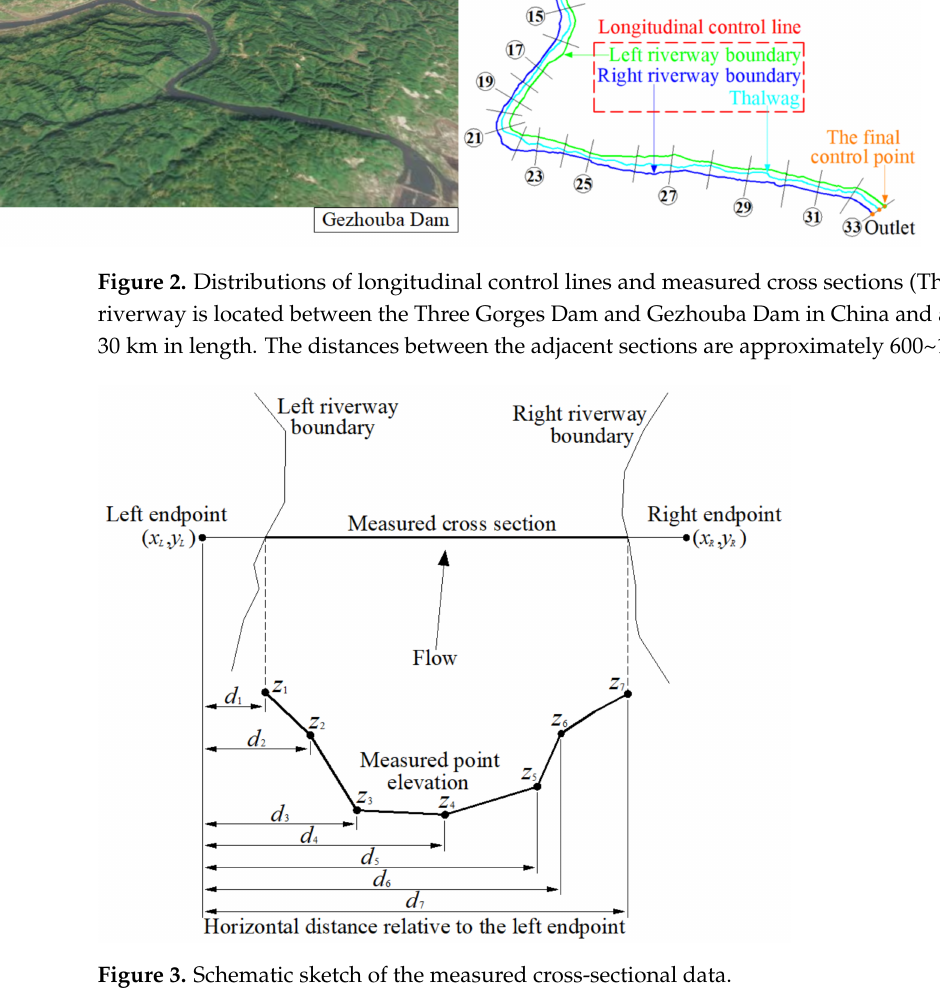
Figure 3. Schematic sketch of the measured cross-sectional